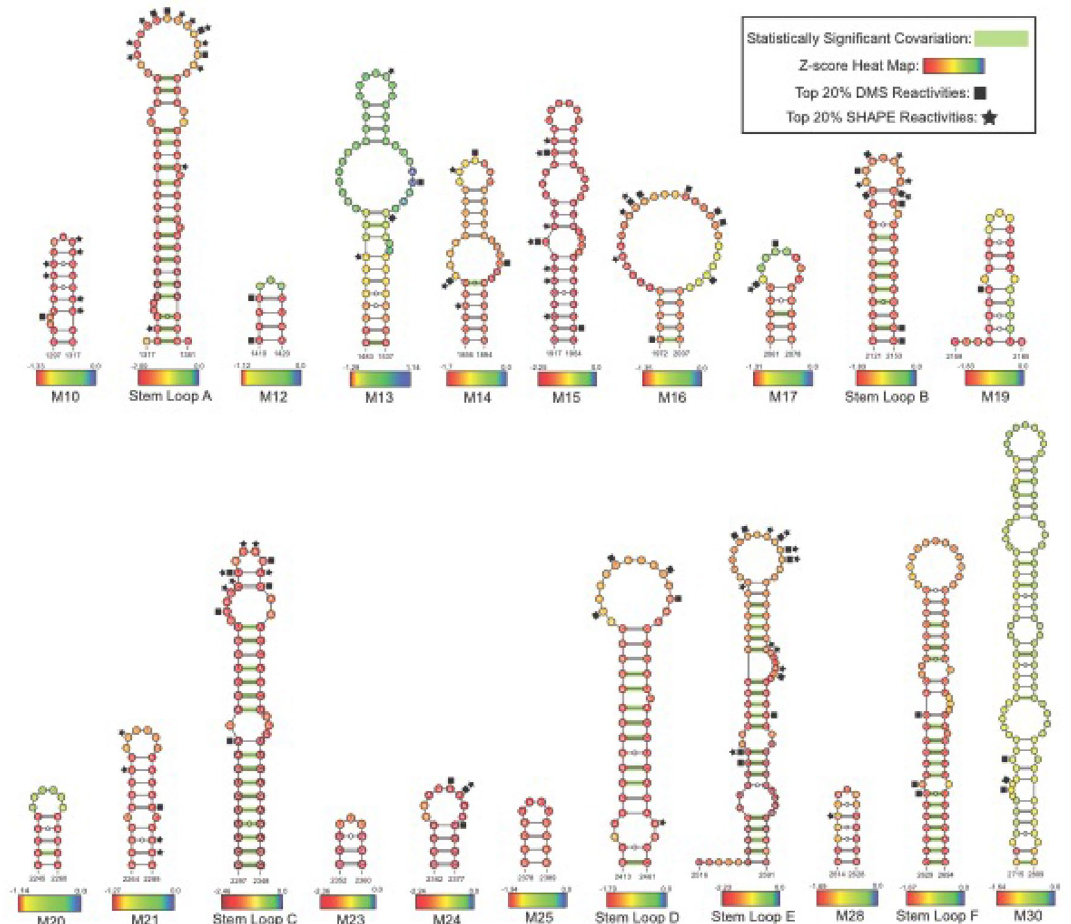
Figure 4. ScanFold predicted structural models of the MAT2A 3 ′ UTR. All novel structures are annotated as M# (Motif #) and all known structures are annotated as in the Rfam database (Stem Loop A–E). Each nucleotide of these structures has been annotated with the per nucleotide z-score from the ScanFold final partners file, with red indicating the lowest z-scores (typically ≤ −2), yellow indicating z-scores ≤ −1, blue indicating z-score of 0, and combinations of these colors indicating z-scores that are in between −2, −1, and 0. All base pairs with statistically significant covariation have been annotated with green bars, and the top 20% of in vivo DMS and SHAPE reactivities have been annotated by squares and stars thermodynamic stability 26,55,56 . Although the general stability of all transcripts was relatively constant, the levels of uniquely stable and potentially functional structures varied. The results from the comparison of average windowed z-scores among the expression datasets demonstrated that the z-scores of transcripts detected in all tissues (HKGs) are higher than those of transcripts detected in a single tissue (Table 1). We find that the lowest and highest average z-scores from “detected in all tissues” are −2.89 (ENST00000527353.1 or PIGY) and +1.49 (ENST00000628044.1 or PFKL), respectively, and the lowest and highest z-scores from “detected in a single tissue” are −1.89 (ENST00000390348.2 or TRGV1) and +1.12